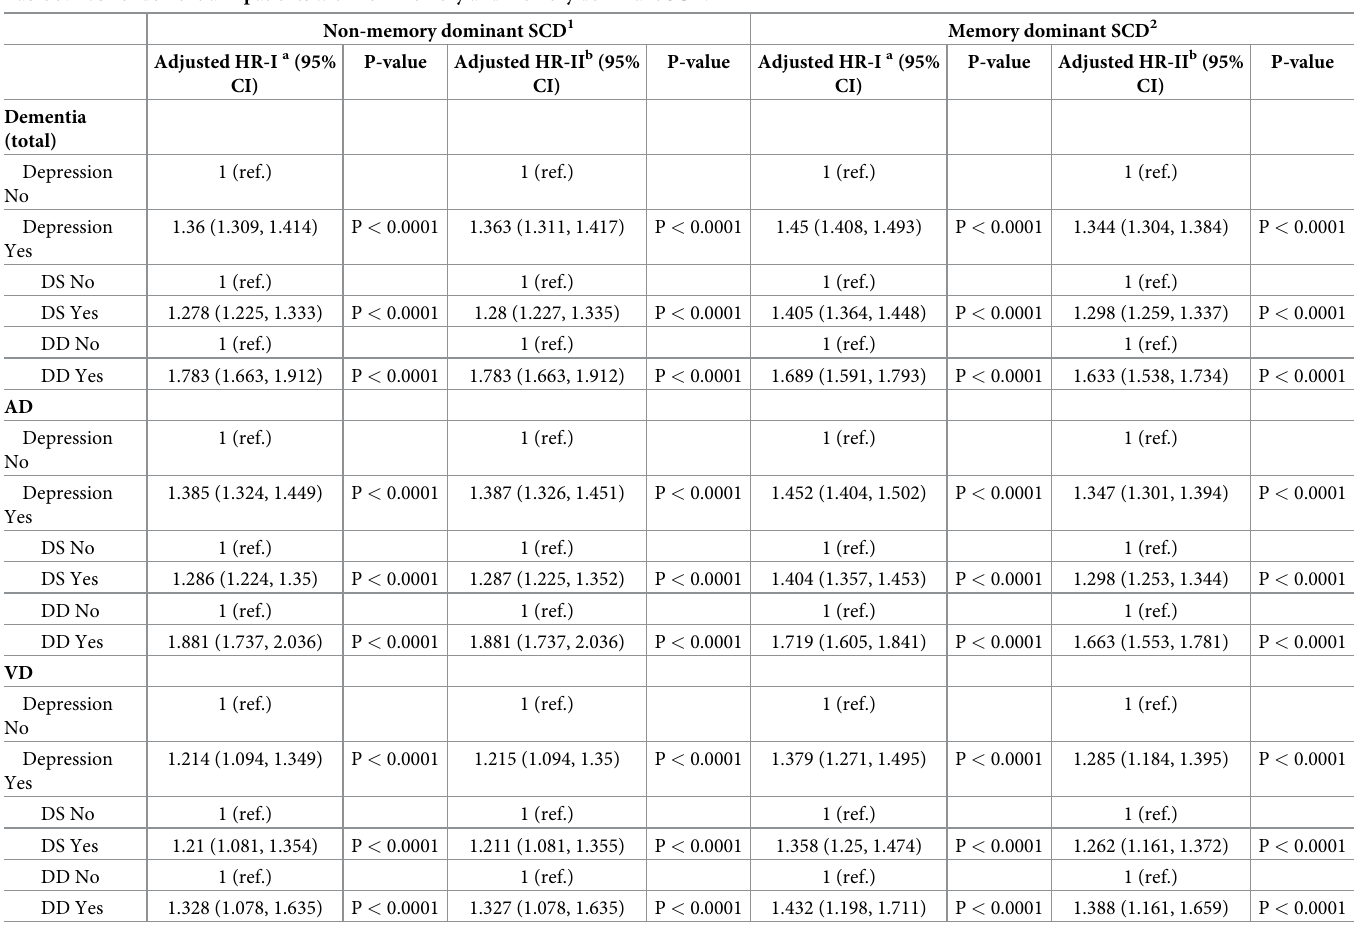
Table 5. Risk of dementia in patients with non-memory and memory dominant